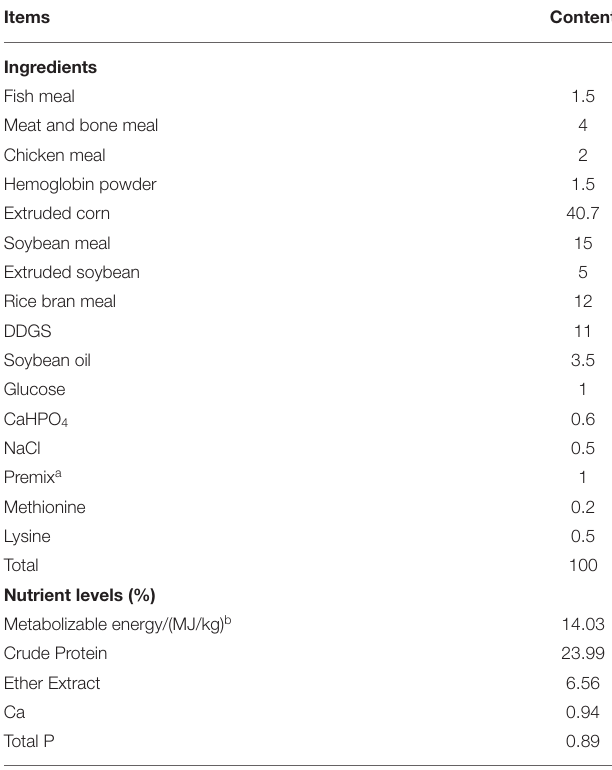
TABLE 1 | Composition and nutrient levels of diets (air-dry basis)